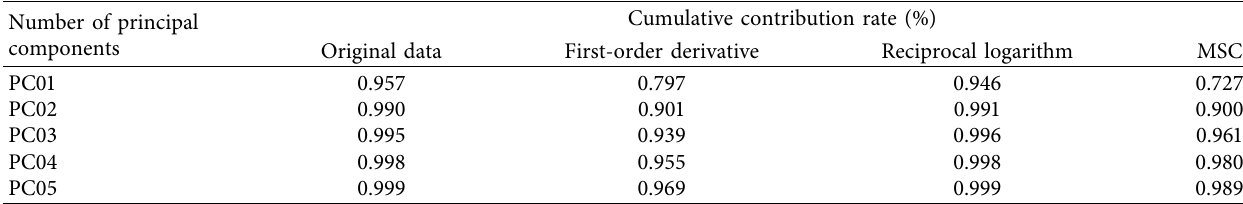
Table 2: Contributions of the top 5 principal